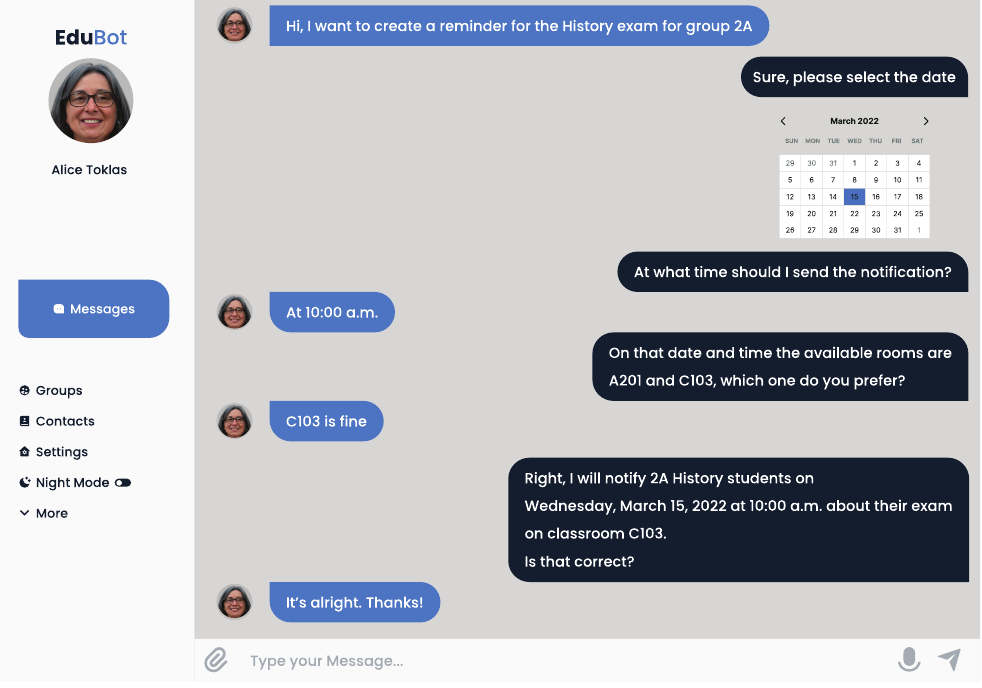
Figure 5. The completion of tasks is facilitated by widgets and asking for missing information; e.g., to schedule an exam, a calendar widget is used, and data that the teacher were not initially provided are